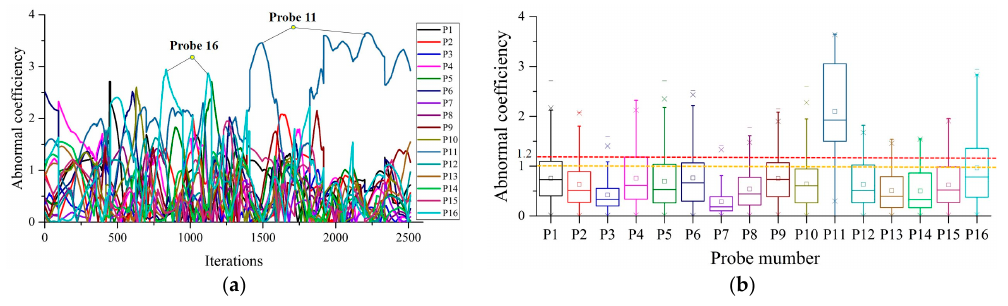
Figure 13. The abnormal coefficient at the first 9 h of Vehicle 2. ( a ) The abnormal coefficient curves; ( b ) Boxplot of the abnormal coefficient.